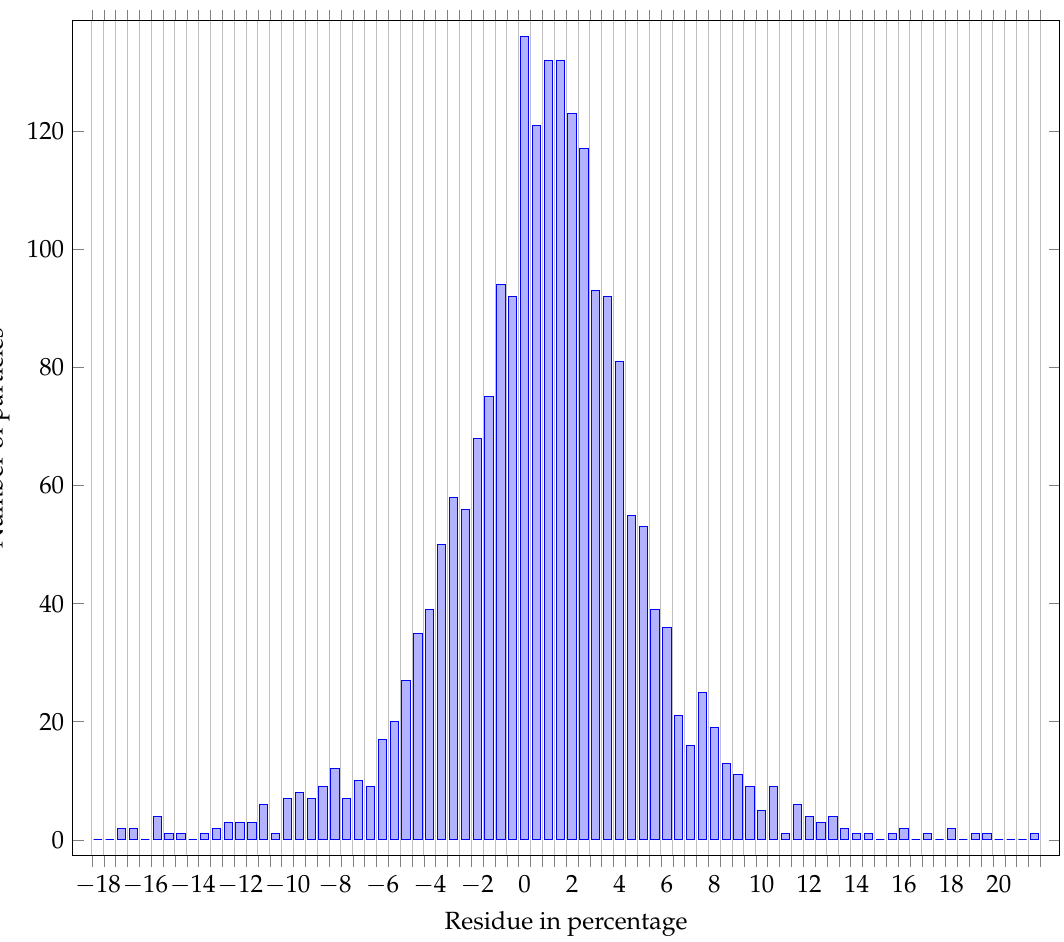
Figure 14. Residue distribution of particle area (in